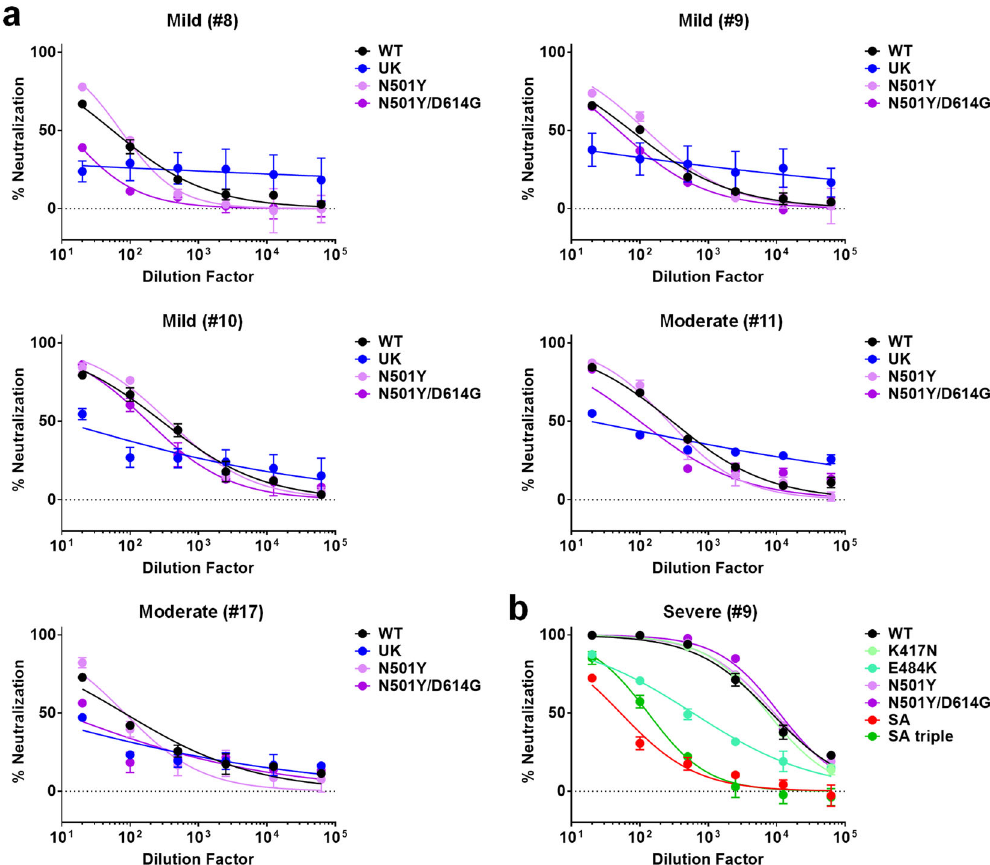
Fig. 3 Pseudovirus neutralization pro fi les of selected convalescent patient plasma against single or double point mutants. a Pseudovirus neutralization assays of fi ve patients, including #8, #9, and #10 from the mild group and #11, #17 from the moderate group. Anti-SARS-CoV-2 neutralizing antibodies from the selected COVID-19 patients were assessed using pseudovirus expressing SARS-CoV-2 Spike glycoprotein of either the original WT strain (black), UK strain (blue), N501Y single point mutant (light purple), and N501Y/D614G double mutant (dark purple) at 1:20 to 1:62500 dilutions. b Pseudovirus neutralization assays of patient #9 from the severe group. Anti-SARS-CoV-2 neutralizing antibodies from the selected COVID-19 patients were assessed using pseudovirus expressing SARS-CoV-2 Spike glycoprotein of either the original WT strain (black), SA strain (red), SA triple strain (green), K417N single point mutant (lime green), E484K single point mutant (light green), N501Y single point mutant (light purple), and N501Y/D614G double mutant (dark purple) at 1:20 to 1:62500 dilutions. Lines represent nonlinear regression fi t and data were shown as mean ± SD of two independent